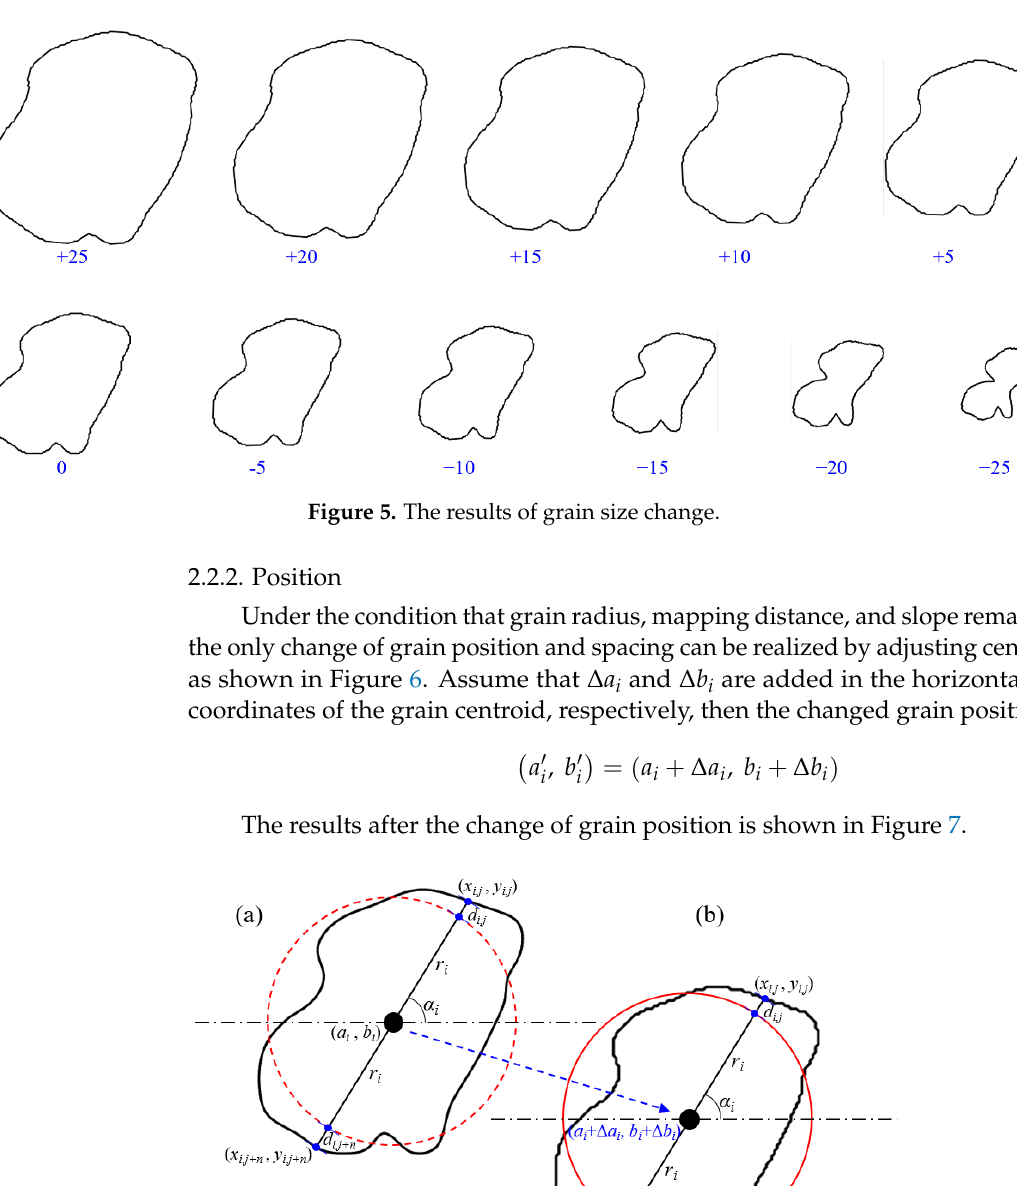
Figure 4. The principle of grain size change. ( a ) Original relationship between grain boundary and mapping circle. ( b ) The relationship between them with the grain radius increasing Δ r i .